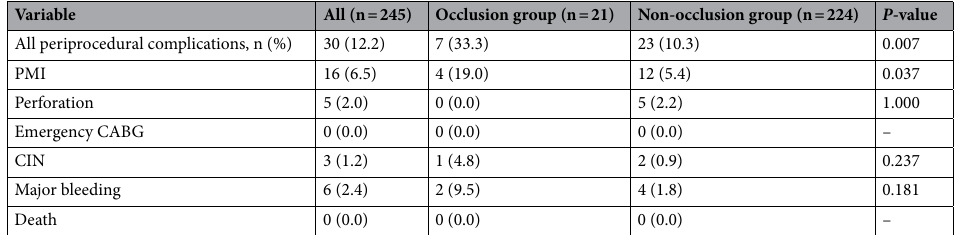
Table 4. Procedural complications. CABG coronary artery bypass grafting, CIN contrast-induced nephropathy, PMI periprocedural myocardial infarction.